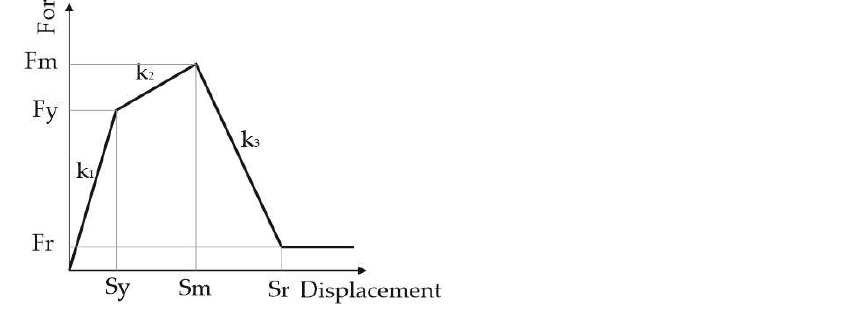
Figure 5. Force-Displacement relationship for the equivalent strut model proposed in [37].